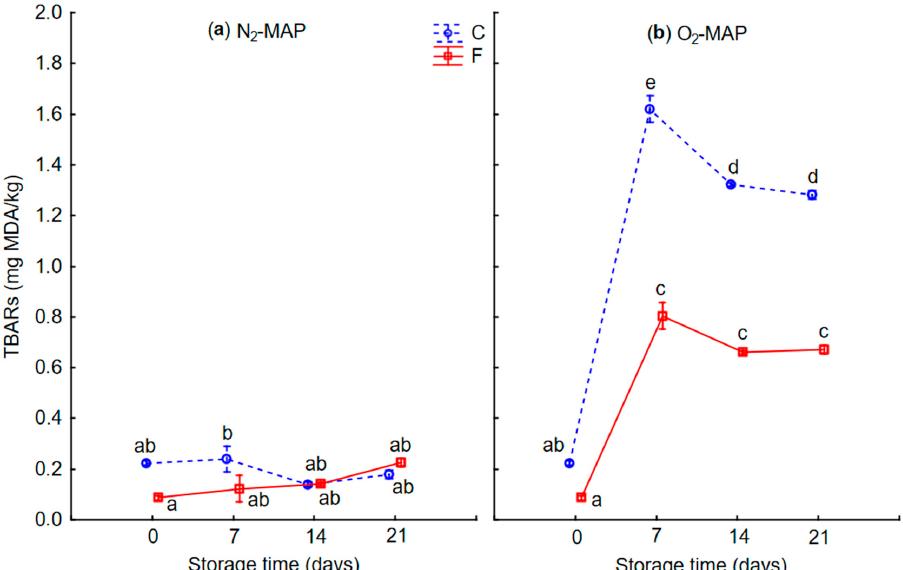
Figure 4. Time-course evolution of the TBARs values measured on 3D-printed products (forms C and F) as a function of MAP conditions (a) and (b), during storage for up to 21 days at 4 °C. N 2 -MAP ( a ): 70% nitrogen (N 2 ) + 30% carbon dioxide (CO 2 ); O 2 -MAP ( b ): 70% oxygen (O 2 ) + 30% carbon dioxide (CO 2 ). Lowercase superscript le tt ers (a–e) indicate signi fi cant di ff erences between samples according to form (C or F), MAP (O 2 -MAP or N 2 -MAP) and time in storage ( p < 0.05). TBARs = ThioBarbituric Acid-Reactive substances. Each point is the mean of 3 replicates ± standard error of the mean (SEM).